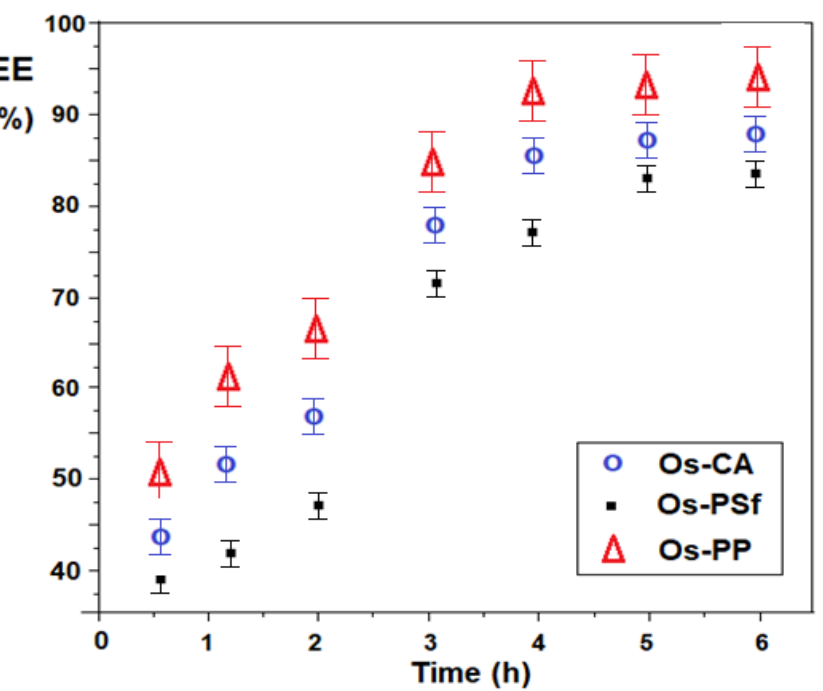
Figure 19. Efficiency of 5–aminobenzimidazol separation depending on the operating time, for the prepared osmium–polymer (Os–P) membranes.